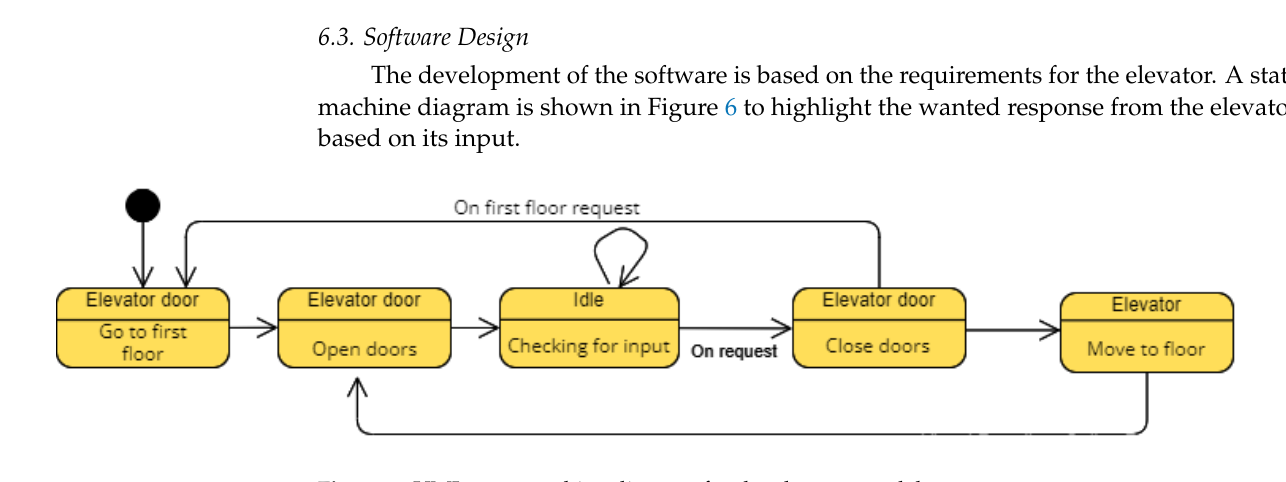
Figure 6. UML state machine diagram for the elevator